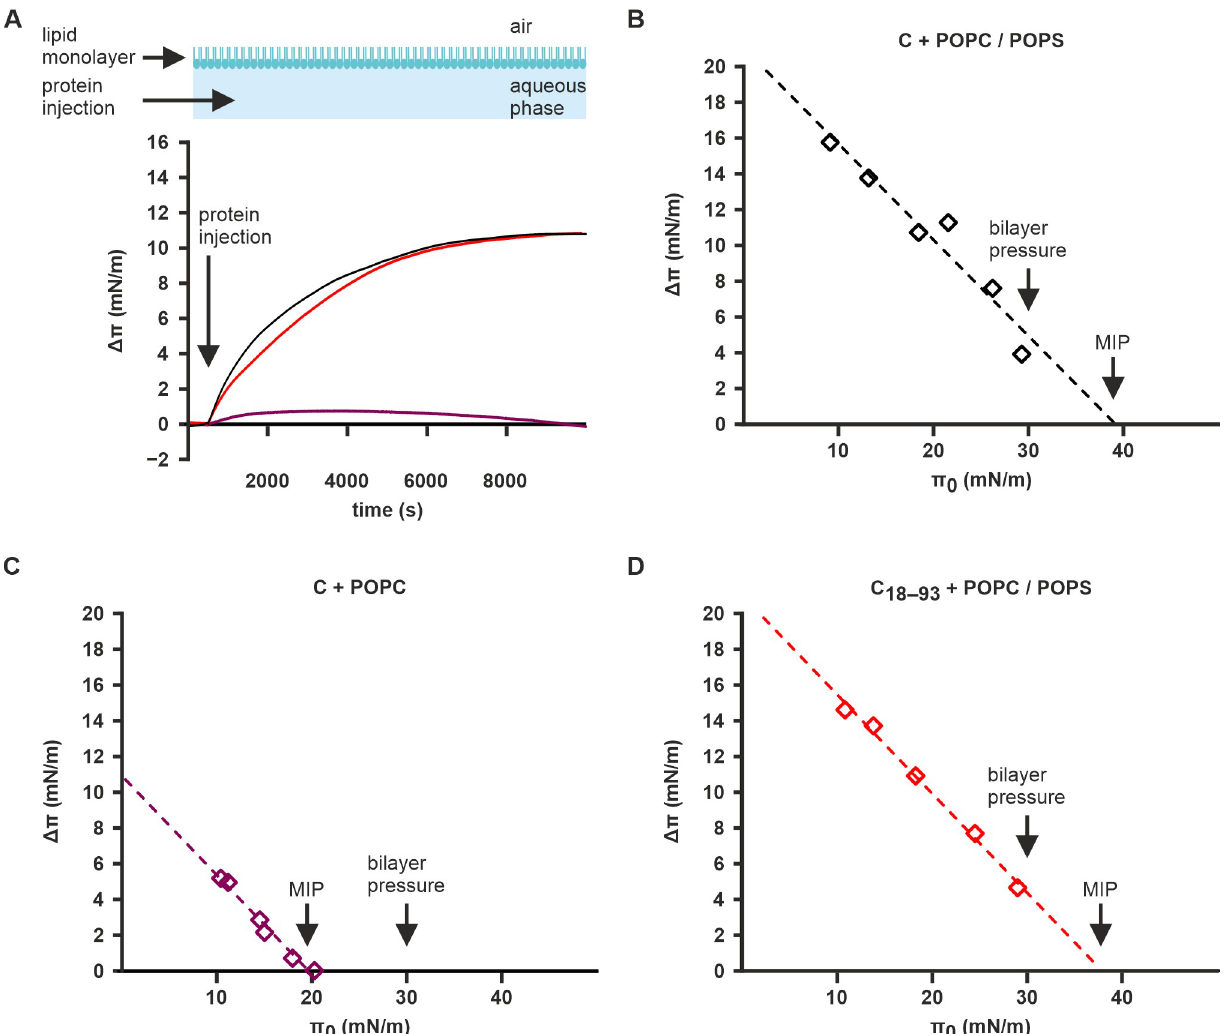
Fig 3. C protein inserts into membranes with negatively-charged lipids. A Representative Δ π curves for C protein injected with a POPC/POPS (black) or POPC (purple) monolayer, and C 18–93 protein injected in with a POPC/POPS monolayer (red) at π 0 values of 18.1 ± 0.2 mN/m . B , C, D MIP curves of C protein with POPC/POPS ( B ) and pure POPC ( C ) monolayers, and C 18–93 with POPC/POPS monolayers ( D ). The pressure of a bilayer ( * 30 mN / m) is indicated along with the MIP [62–64]. Data information. In ( A ), π is zeroed to π 0 . The Individual measurements in ( B ), ( C ), and ( D ) are shown as diamonds. The R 2 values in ( B ), ( C ), and ( D ) are 0.9344, 0.9818, and 0.9935,